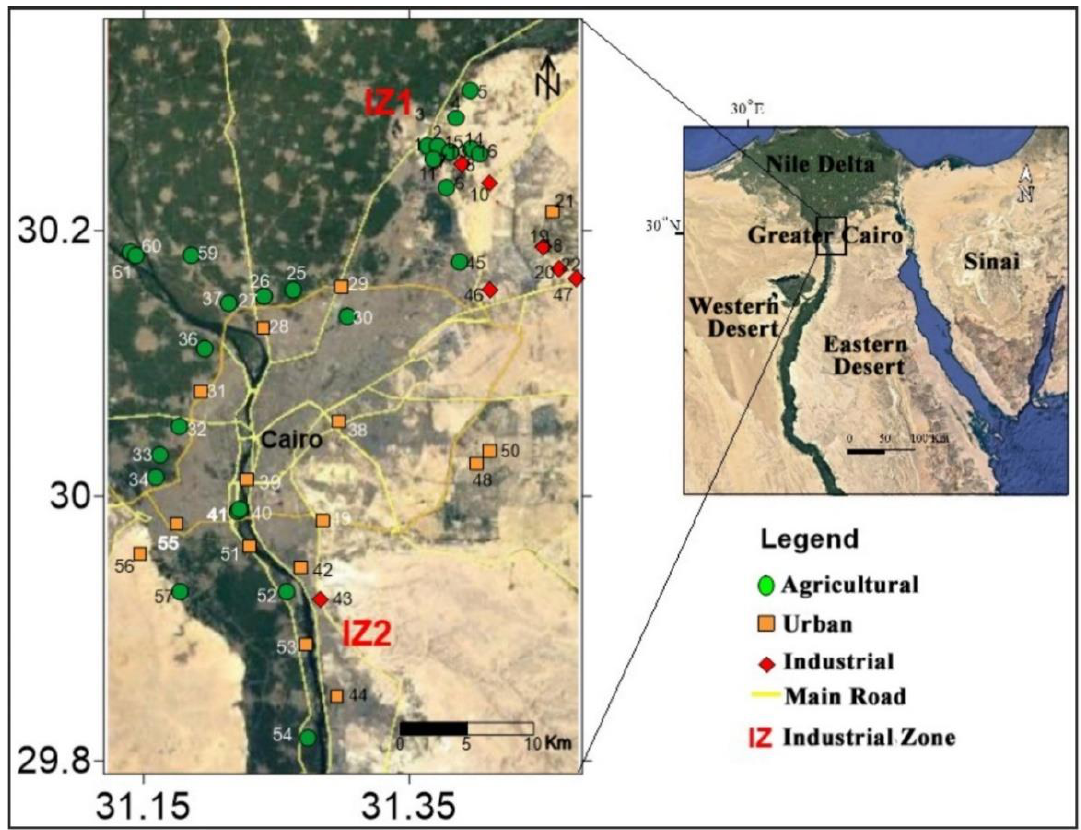
Figure 2. Map displaying the study area and sampling sites.